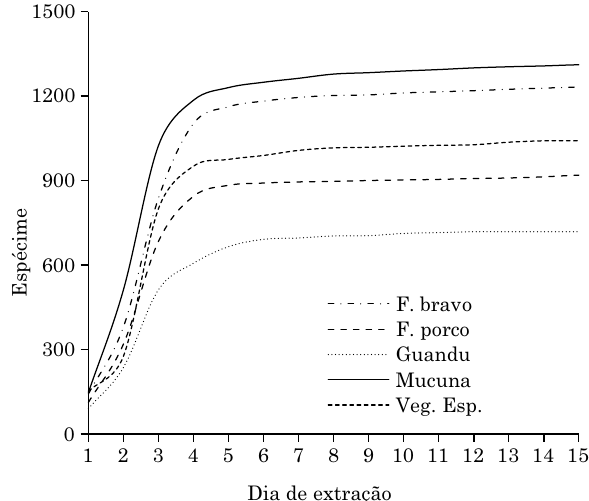
Figura 8. Variação diária da quantidade de organismos capturados, discriminada por tratamentos [feijão-de-porco ( Canavalia ensiformis ), mucuna-preta ( Mucuna aterrima ), feijão-bravo-do-Ceará ( Canavalia brasiliensis ), guandu ( Cajanus cajan ) e vegetação espontânea], referente à segunda